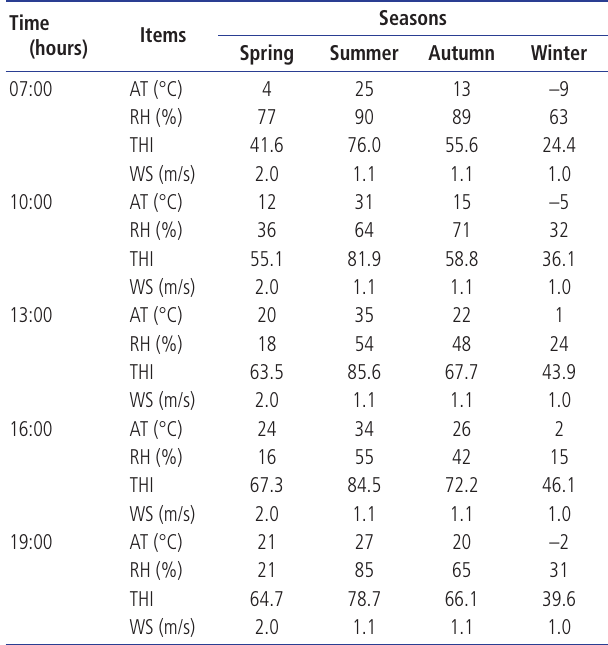
Table 1. Chemical composition of experimental diets Items